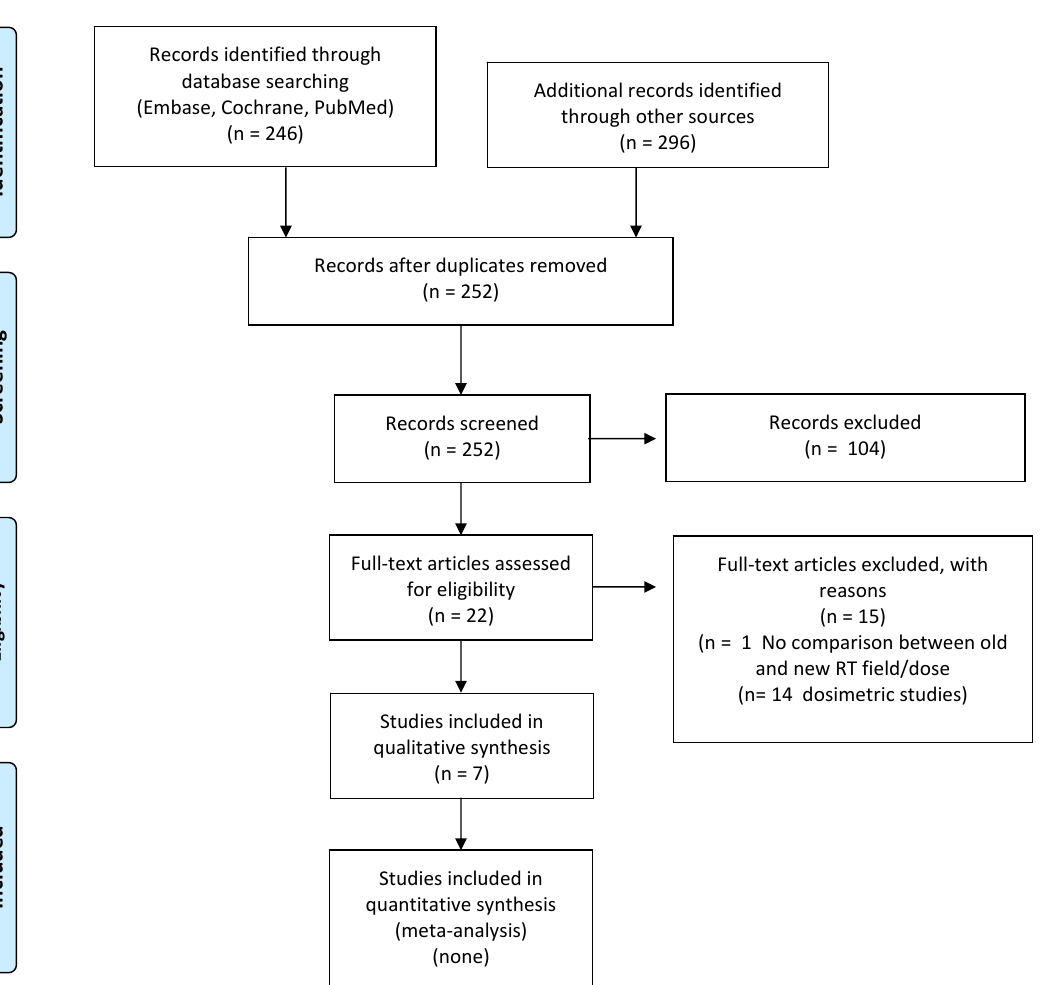
Figure 2. PICO B: PRISMA flow-chart for impact of modern RT on incidence of second cancer. Patel et al. [37] recorded a significant reduction in all-cause mortality (also second tumors) in 1541 patients with early-stage cHL treated with RT with or without CHT in the most recent era, as compared to those treated in earlier time periods. In fact, the 15-year OS rates were 78%, 85%, and 88% ( p = 0.0016), for patients treated during the